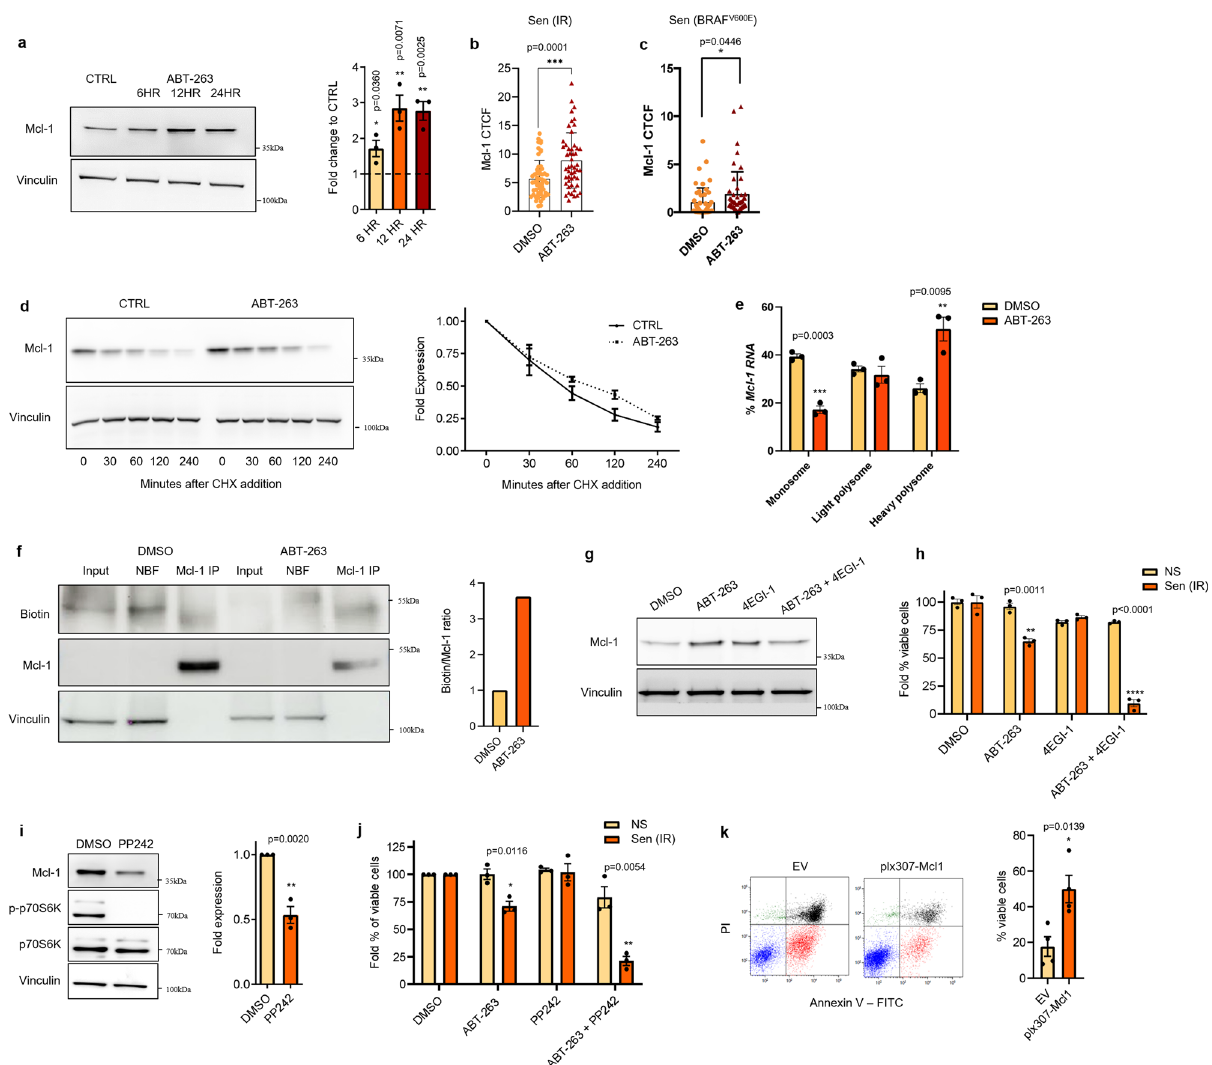
Fig. 2 | Mcl-1 translation meditates resistance to ABT-263 in senescent mela- nocytes,whichcanberepressedthroughmTORinhibition.a Proteinexpression and densitometry analysis of MCL-1 in irradiated melanocytes treated with 5 µ M ABT-263after6,12,or24h.Correctedtotalcell fl uorescenceofMCL-1insenescent b irradiatedand c BRAF V600E expressingmelanocytestreatedfor24hwithDMSOor ABT-263. d Cycloheximide chase experiment of MCL-1 in DMSO and ABT-263 treated irradiated melanocytes. Cells were incubated with DMSO or 5 µ M ABT-263 for 12h, after which 5 µ g/ml cycloheximide was added. Protein lysates were obtained after the indicated time points and used for Mcl-1 immunoblotting. Quanti fi cation of MCL-1 degradation rates was carried out using densitometry analysis with vinculin as a housekeeping protein. Expression was normalized to protein levels at time point 0. e Distribution of Mcl-1 mRNA in monosome, light polysome, or heavy polysome fractions from irradiated melanocytes treated with DMSO or 5 µ M ABT-263 for 16h. Distribution of β -actin mRNA was used to nor- malize values. f Immunoblot of immunoprecipitated MCL-1 in vehicle or ABT-263 treated irradiated melanocytes showing nascent (biotinylated) MCL-1 synthesis.